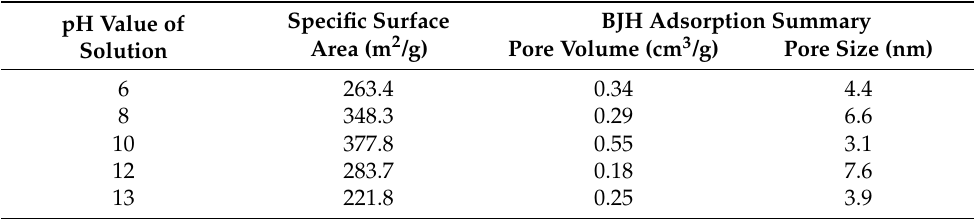
Table 2. Effect of solution pH value on physical properties of the nanosized powder.